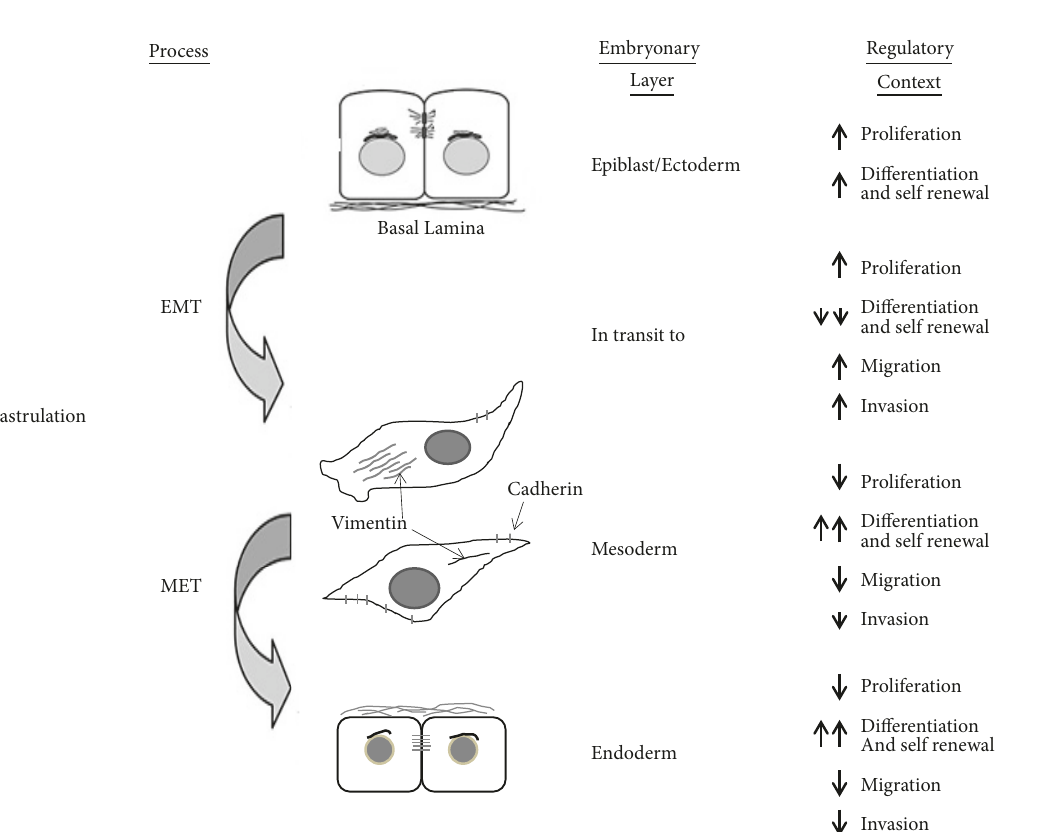
amino-terminal domain of Kaiso specifically interacts with its partner catenin p120 (p120ctn) [21]. A fascinating function